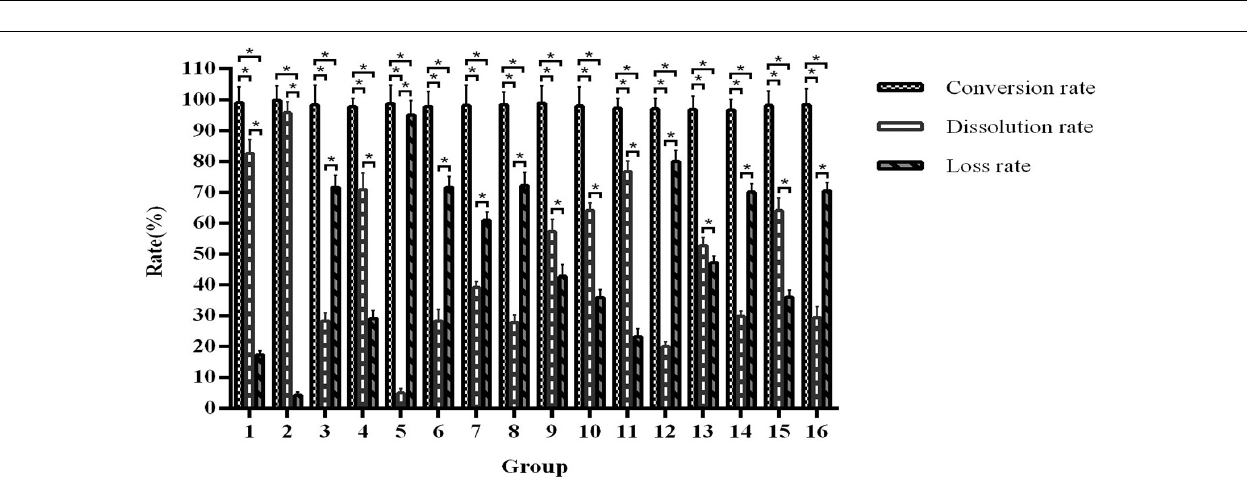
FIGURE 7 | The influence of inoculation volume on fermentation efficiency. *Indicates significance at the 0.01 level.